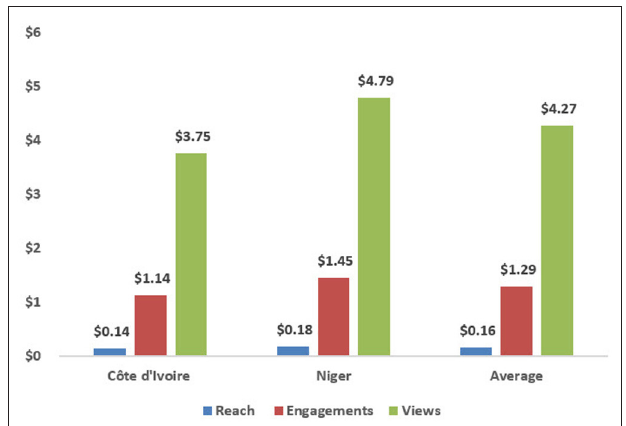
FIGURE 1 | MMH video unit cost by exposure level.